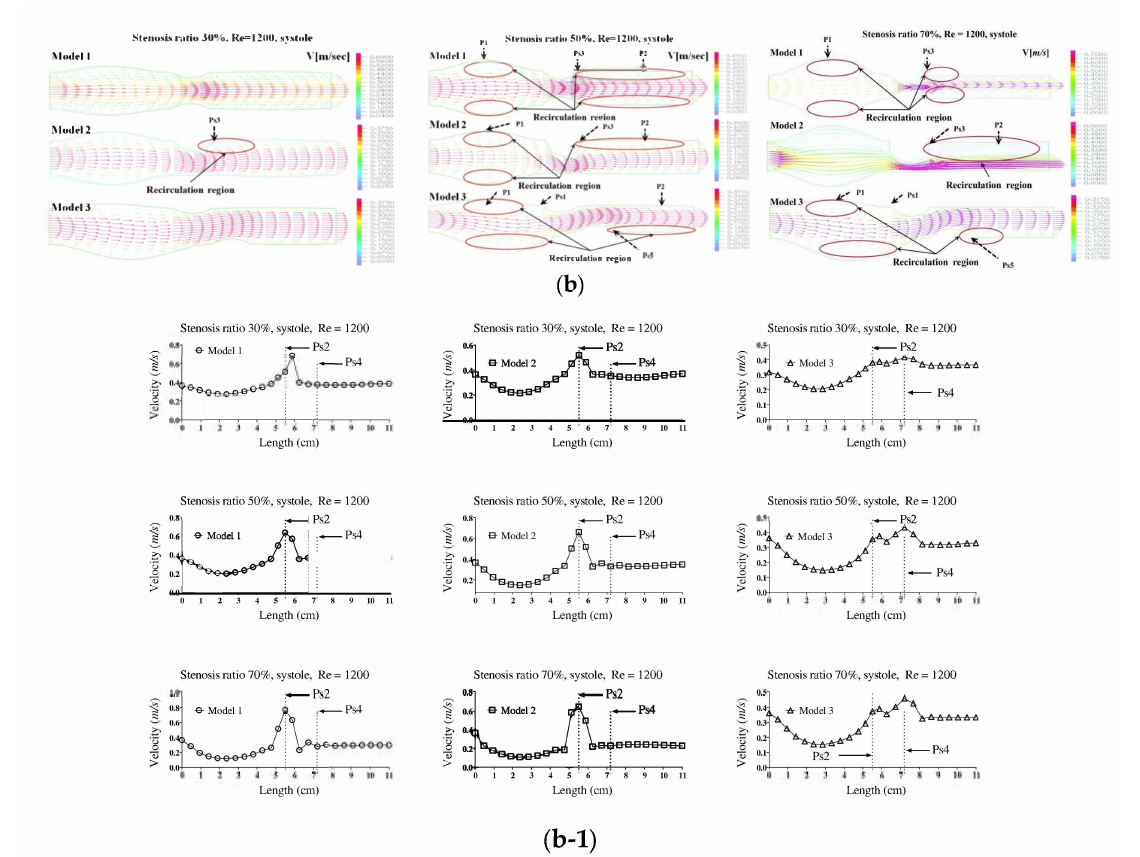
Figure 2. The velocity distribution and average velocity in the pulsatile flow field based on changes to the stenosis ratio at each point of the modules. ( a ) Diastolic velocity distribution and ( a-1 ) diastolic average velocity; ( b ) systolic velocity distribution and ( b-1 ) systolic average